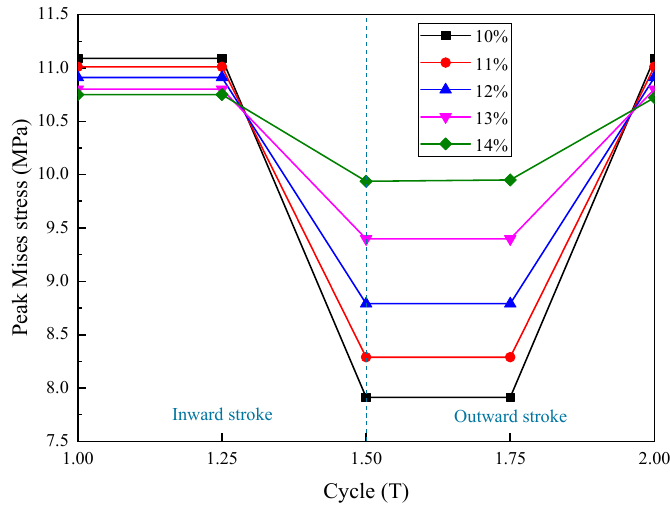
Figure 16. The relationship between peak Mises stress and R p during 1–2 T.